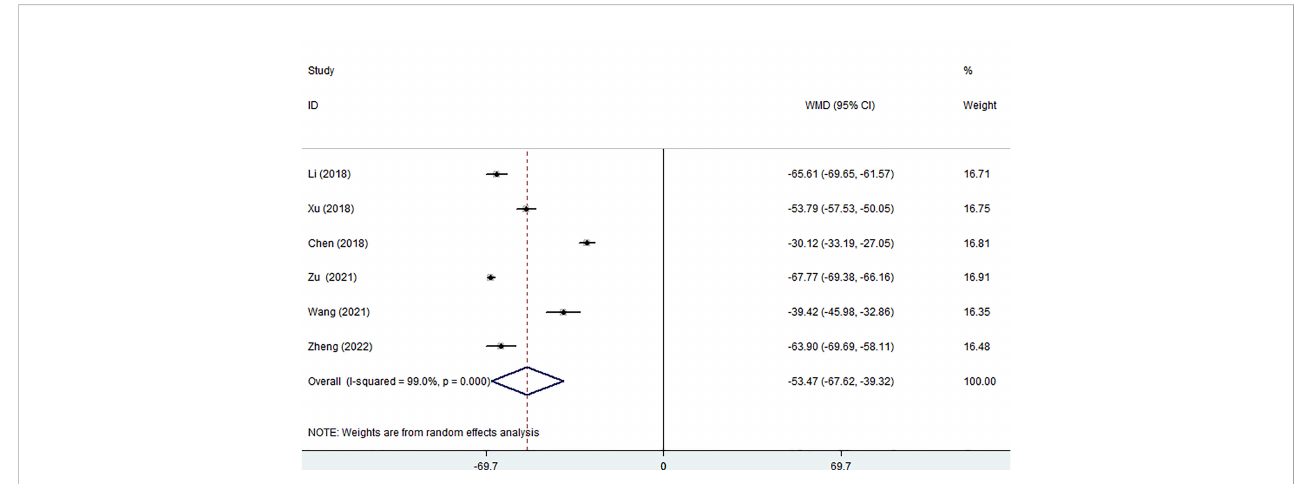
FIGURE 2 Forest plot of the operation time for comparing MWA with surgery in patient with PTMC. MWA, microwave ablation, PTMC, papillary thyroid